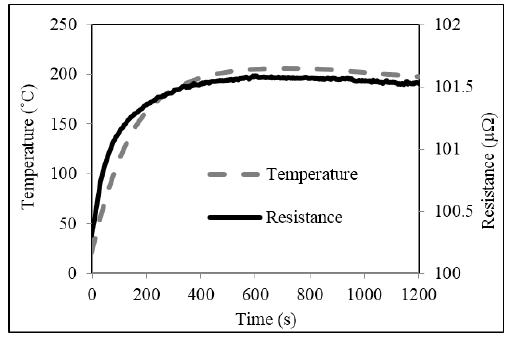
Figure 8. Temperature and resistance versus time plots for the shunt resistor trimmed with the square cut.